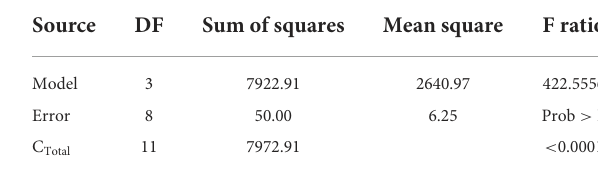
TABLE 8 Variance analysis of experimental design results.